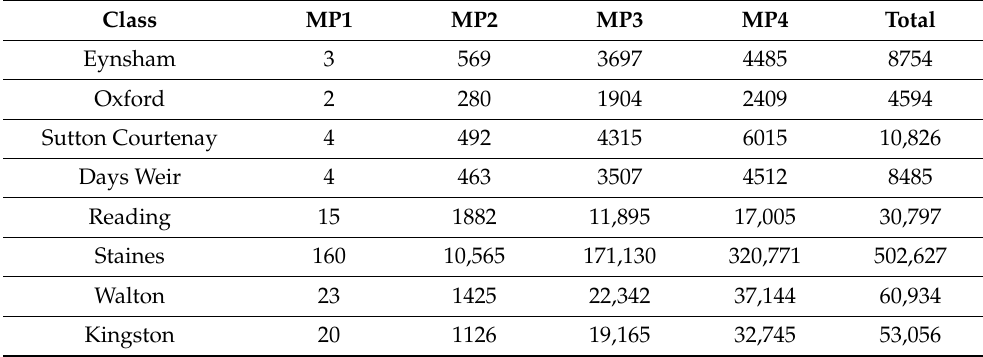
Table 4. Average annual suspended microplastics mass load (kg/year) by microplastic particle size and by river reach (scenario 3).